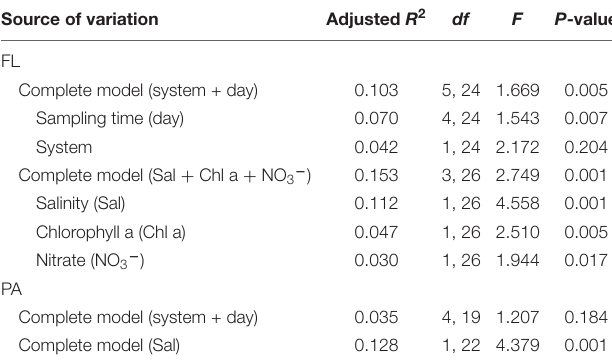
TABLE 5 | Contribution and significance of observe environmental factors which explain the variation in community composition of the free-living (FL) and the particle-attached (PA) fractions based on redundancy analysis